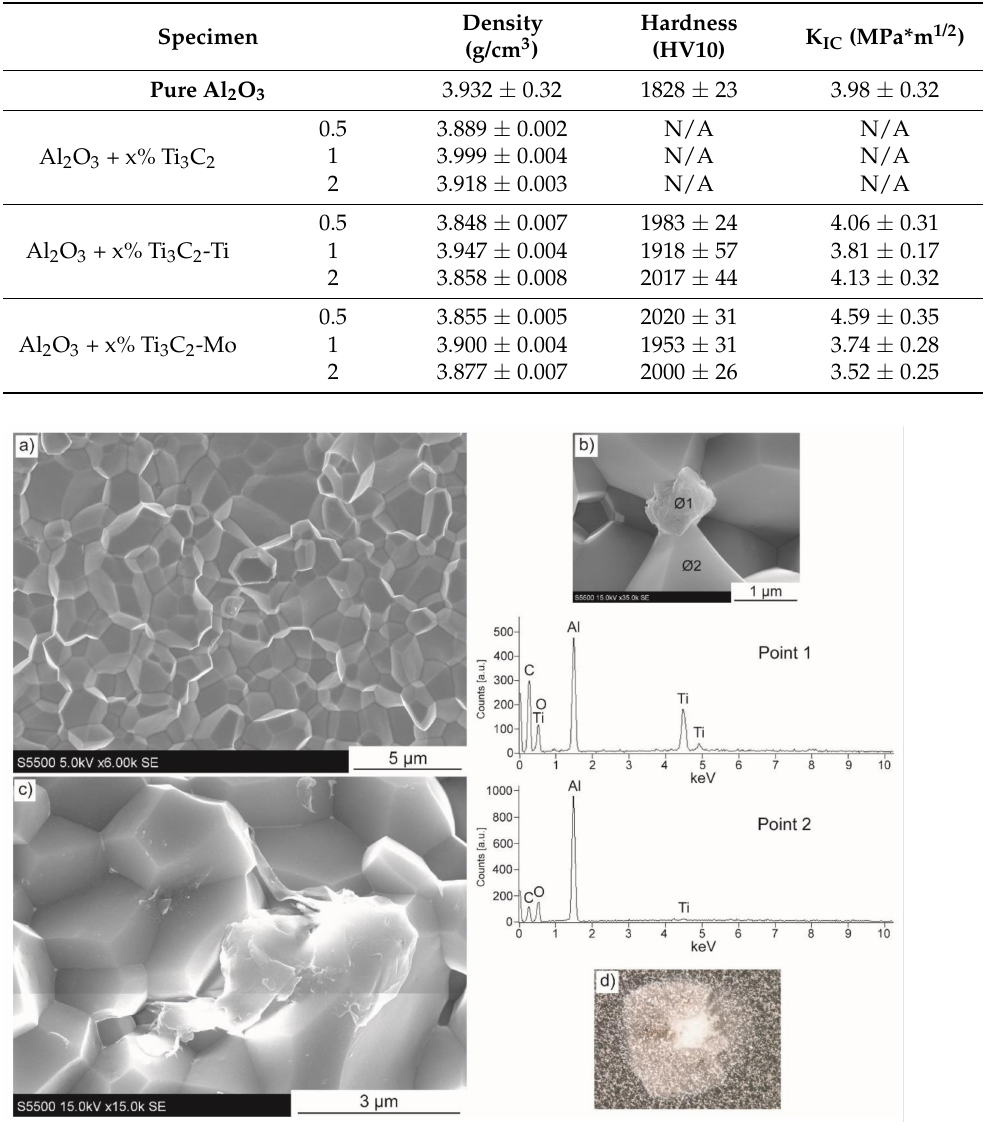
Figure 6. Microstructure images of composites with Ti 3 C 2 addition of ( a ) 1 wt.%, ( b ) 1 wt.% with energy-dispersive X-ray spectroscopy (EDS) points analysis, ( c ) 2 wt.%, ( d ) 0.5 wt.% with Vickers indenter